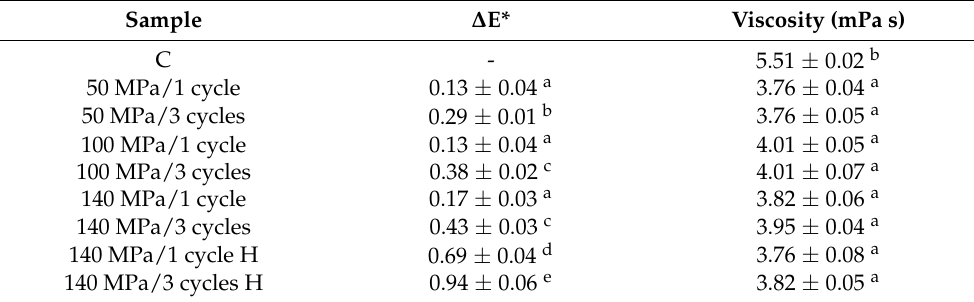
Table 3. Influence of HPH processing on beetroot juice color and